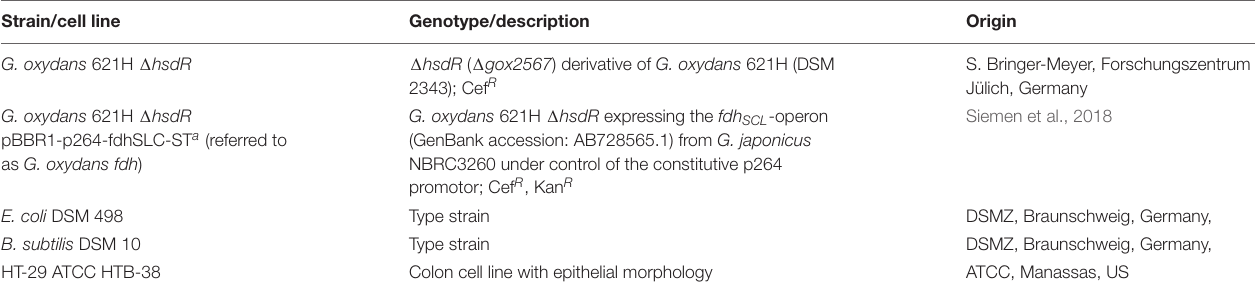
TABLE 1 | Overview of utilized strains and cell